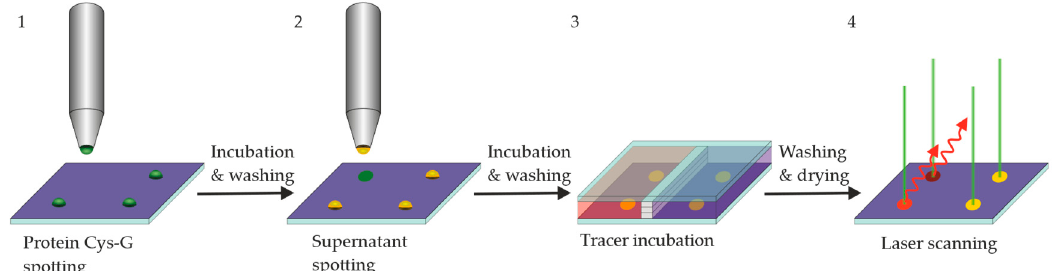
Figure 5. A general approach for the chip-based screening: 1. Printing of Cys-Protein-G on an epoxy-silanized glass slide (may be prepared in advance); 2. Printing of mAb supernatants; 3. Incubation of labeled antigen/hapten. In separate chamber(s), but on the same slide, competition experiments can be performed; 4. Laser scan to quantify fluorescence signals.